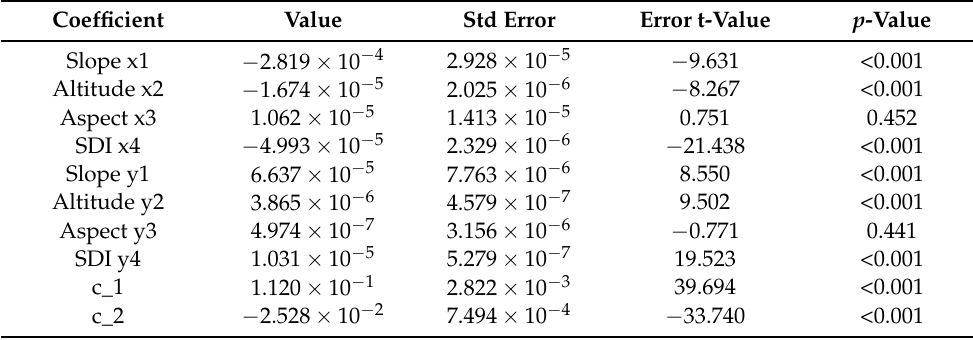
Table 1. Coefficients of the NLM. RMSE = 0.2207 cm/year on 8621 degrees of freedom.